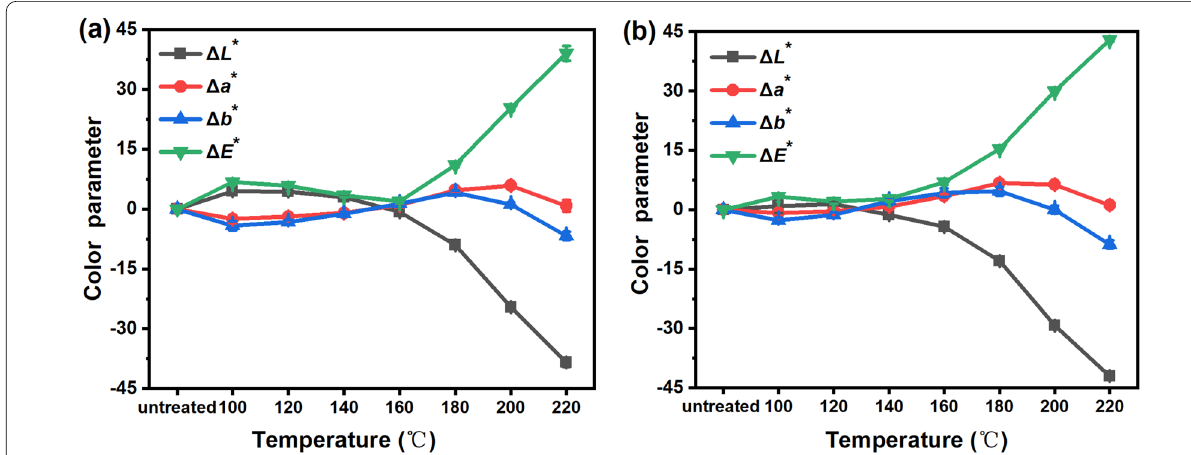
Fig. 3 Changes in color parameters of a fibers and b parenchyma cells